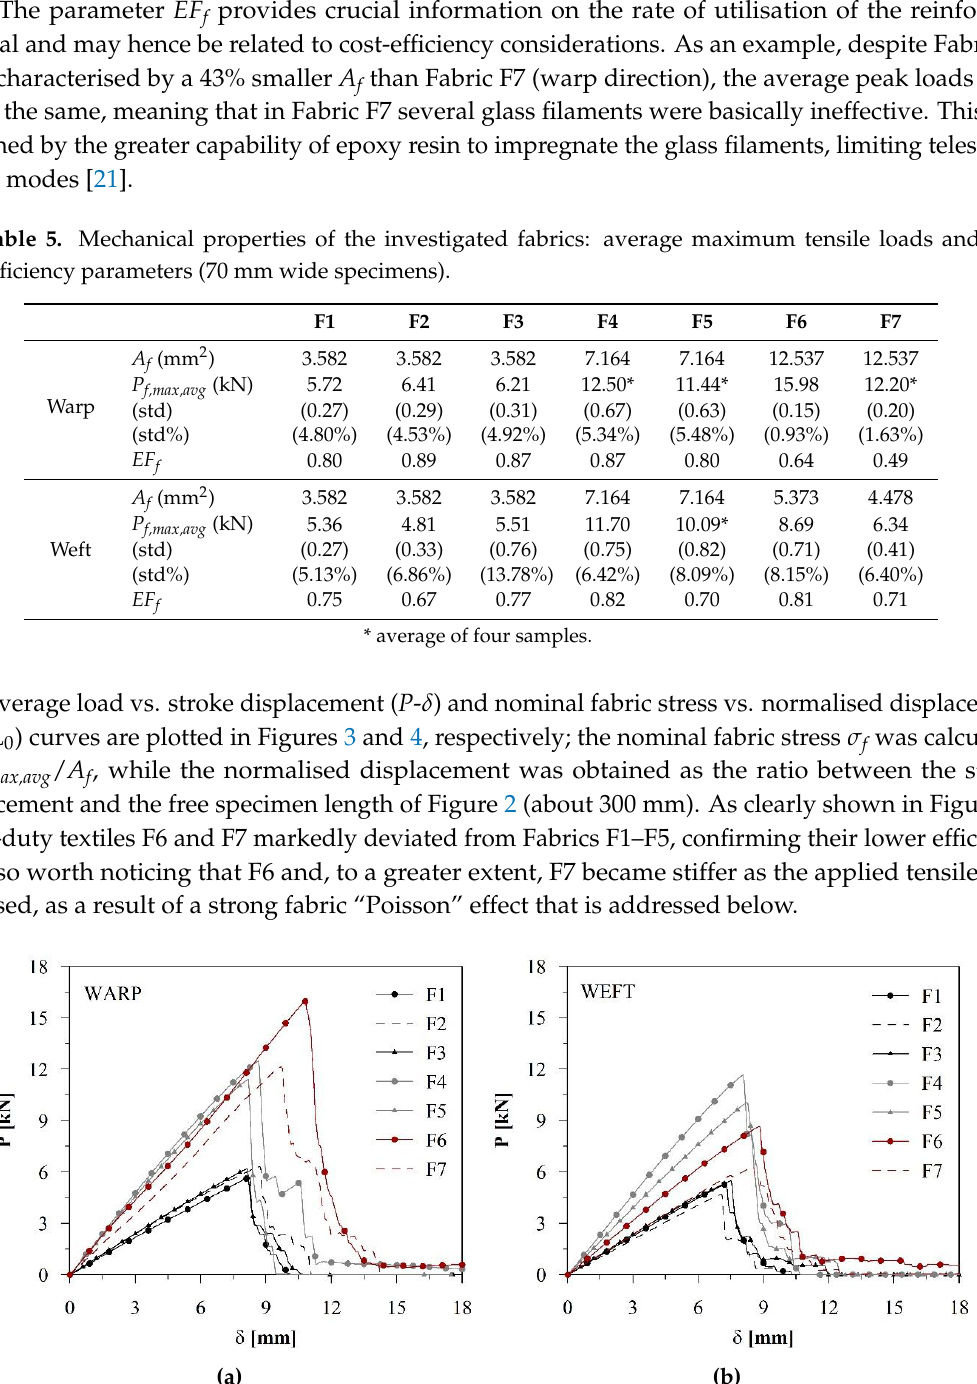
( b ) Figure 4. Fabric average tensile responses in terms of fabric stress vs. normalised displacement: in the warp direction ( a ); and in the weft direction ( b ).